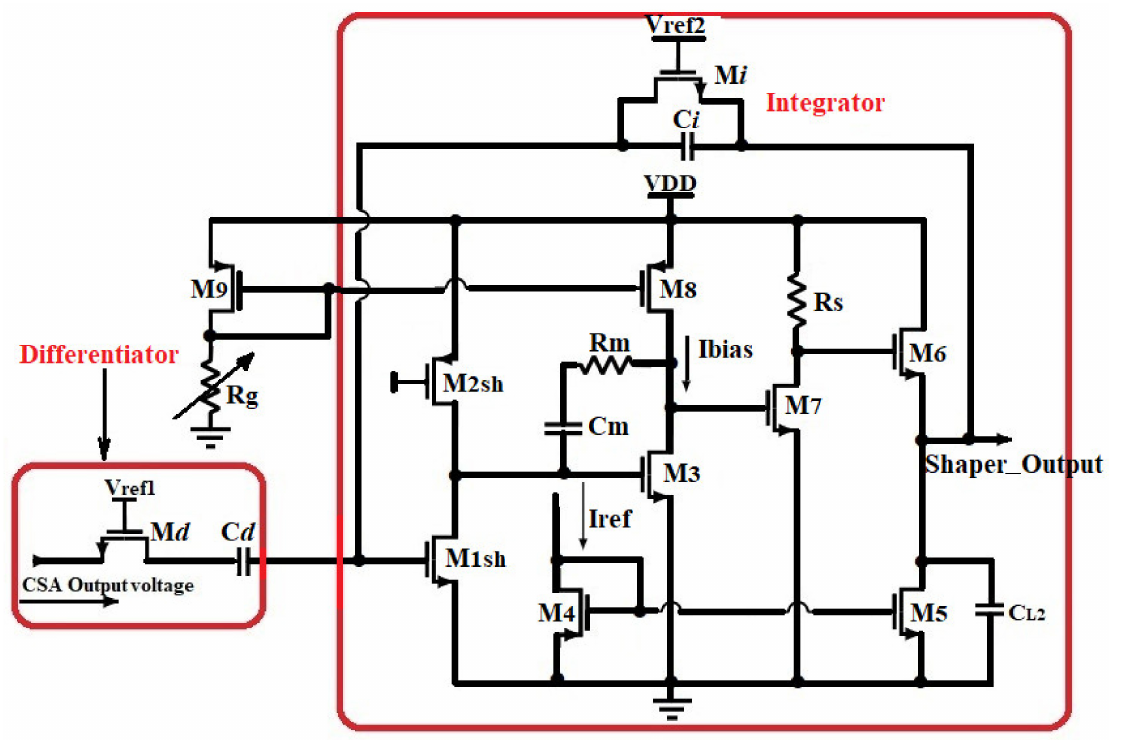
Figure 6. Schematic of the proposed structure of the